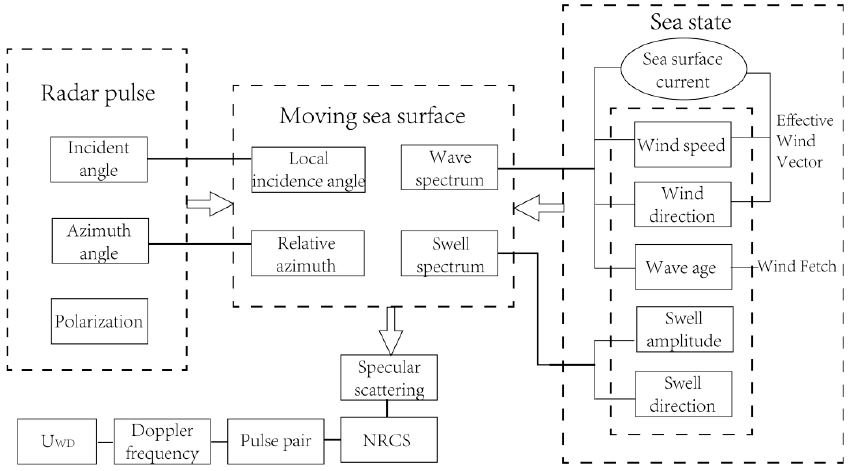
Figure 3. Flowchart of U WD numerical simulation in Ka-band real-aperture radar with small incidence angle.